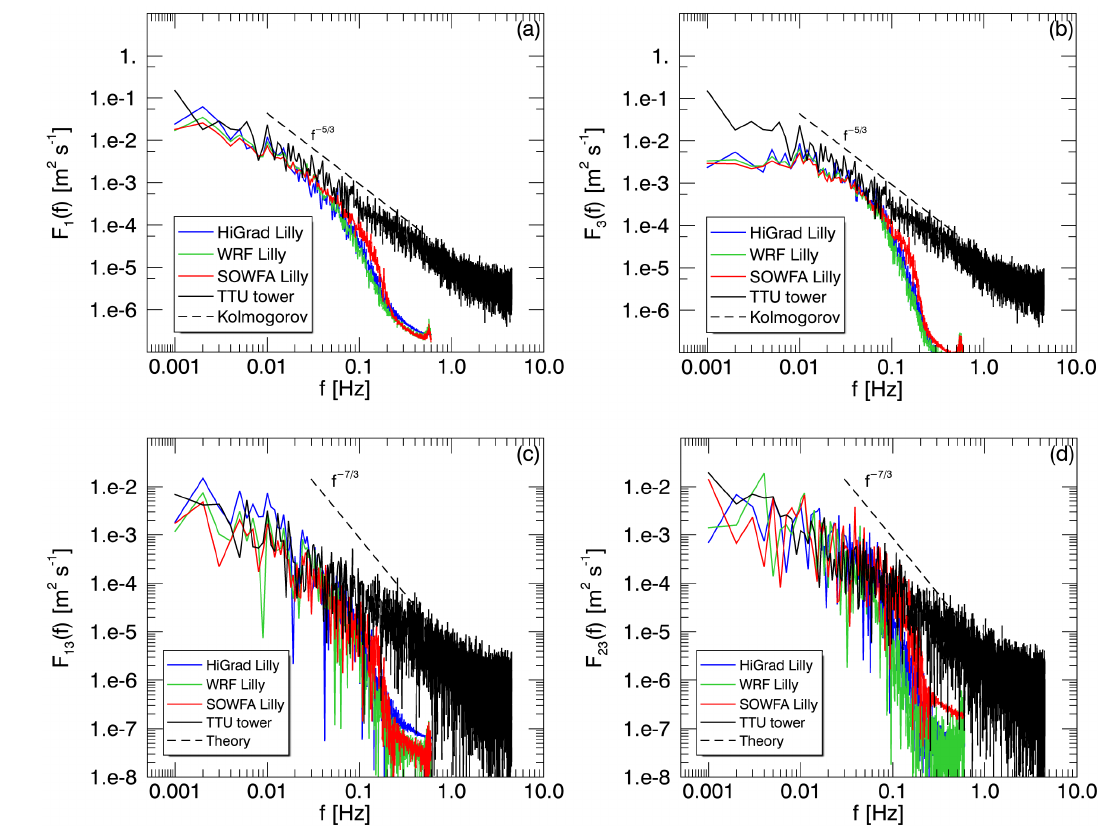
Figure 13. Simulated and measured spectra and cospectra, as in Fig. 12, from another neutral case study occurring 10 July 2012, exhibiting no tower wake effects.